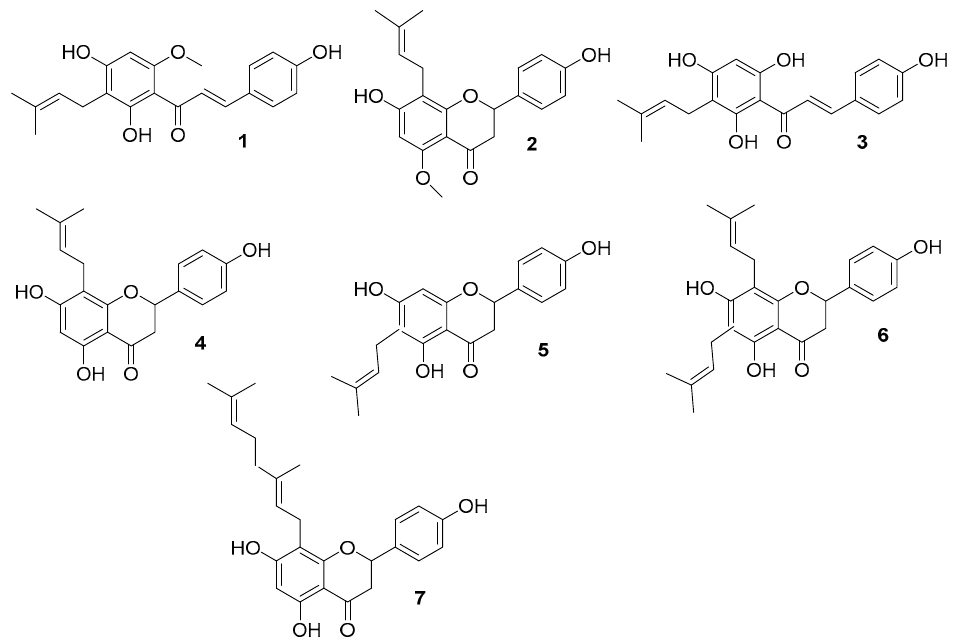
Figure 2. Structures of described flavonoids: xanthohumol XN ( 1 ), isoxanthohumol IX ( 2 ), desmethylxanthohumol DMX ( 3 ), 8-prenylnaringenin 8-PN ( 4 ), 6-prenylnaringenin 6-PN ( 5 ), 6,8-diprenylnaringenin 6,8-DPN ( 6 ), 8-geranylnaringenin 8-GN ( 7 ).